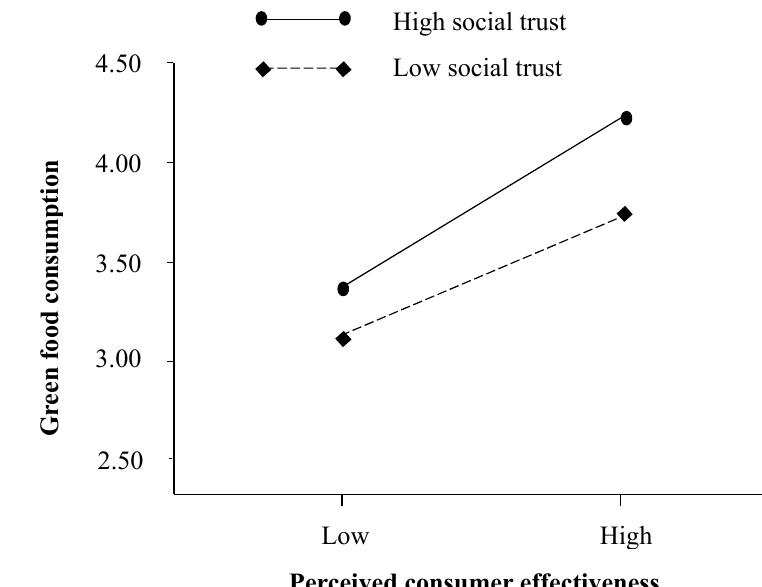
Figure 3. Moderating effect of social trust.